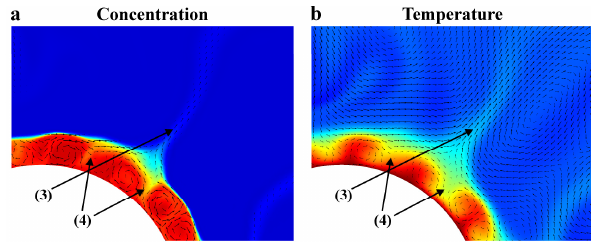
Figure 3. (a) Concentration of the dense material and (b) tempera- ture field demonstrating the processes of (3) erosion and (4) dilution of the dense layer. Black arrows denote the logarithmically scaled (a) mass flux of the dense material and (b) flow velocity.